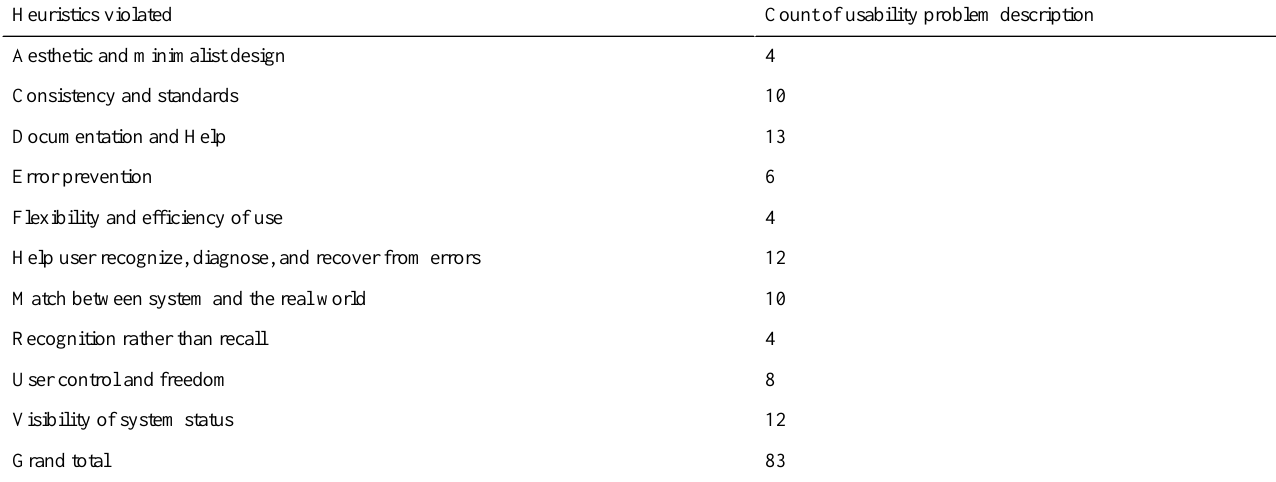
Table 2. Number of the heuristic violations across the heuristics.